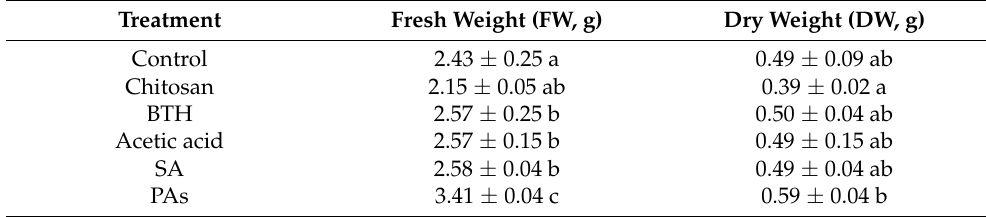
Table 1. Effect of the elicitors on leaf fresh weight and leaf dry weight after 15 days of treatment. Statistically homogenous groups are identified by letters (Duncan’s post-hoc, p ≤ 0.05).